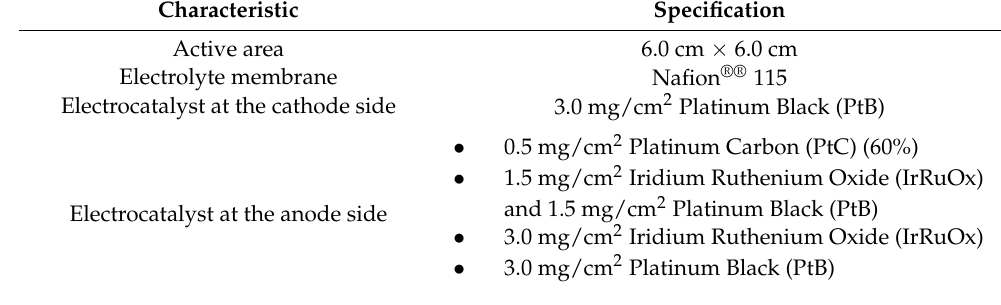
Table 1. MEA Specifications.